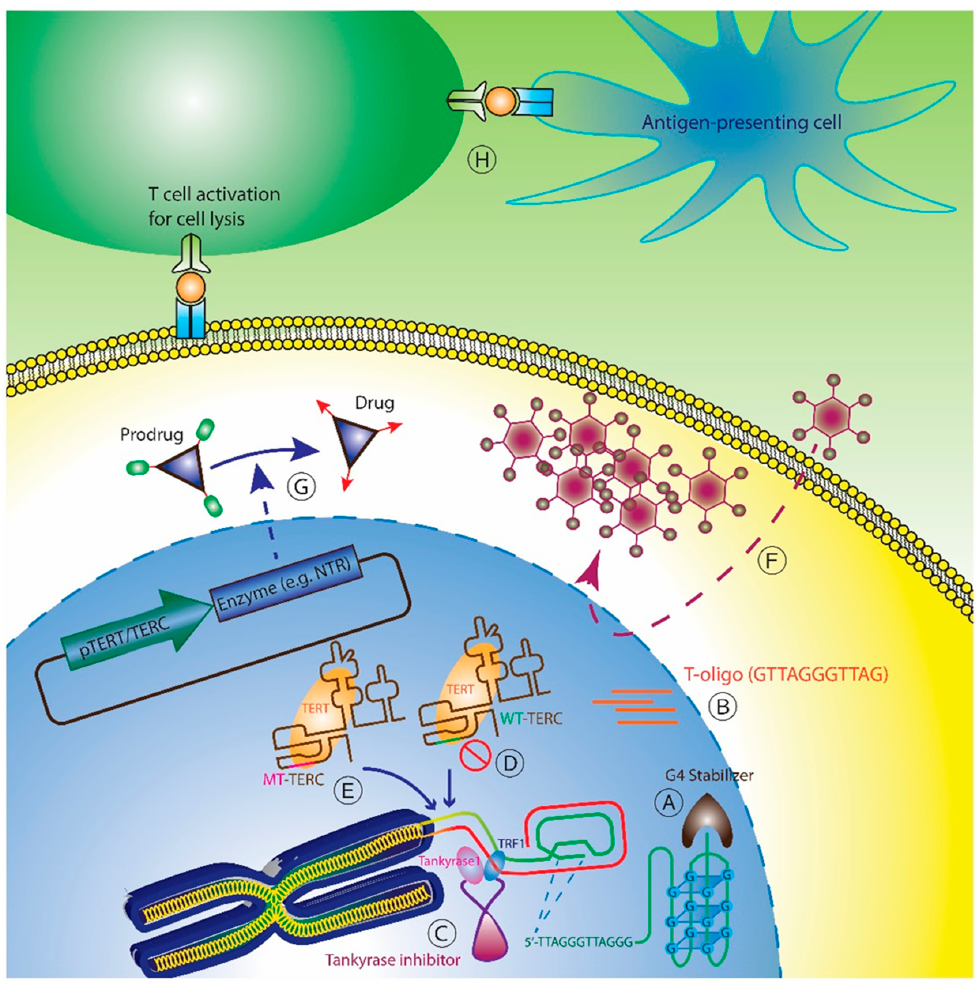
Figure 1. Overview of telomerase therapeutic strategies. Several telomerase-based therapeutic approaches have been developed: ( A ) G-quadruplex stabilizers prevent unwinding of the quadruplex, making the 3’ overhang inaccessible to telomerase; ( B ) Telomeric oligos (T-oligo) mimic uncapped telomeres and elicit a DNA damage response; ( C ) Tankyrase inhibitors inhibit dissociation of TRF1 from telomeres, rendering them less accessible to telomerase; ( D ) Direct inhibition of telomerase enzymatic activity via an oligonucleotide (Imetelstat) that binds TERC template; ( E ) Telomerase interference (MT-TERC) that reprograms telomerase to add mutant telomeric repeats that elicit a DNA-damage response; ( F ) TERT promoter driven oncolytic viruses that cause tumor-specific cell lysis; ( G ) Suicide gene therapy that employs TERT or TERC promoter-driven expression of enzymes that convert pro-drugs to active cytotoxic molecules; ( H ) Telomerase vaccines that induce cytotoxic T lymphocyte by either direct inoculation or ex vivo activation.